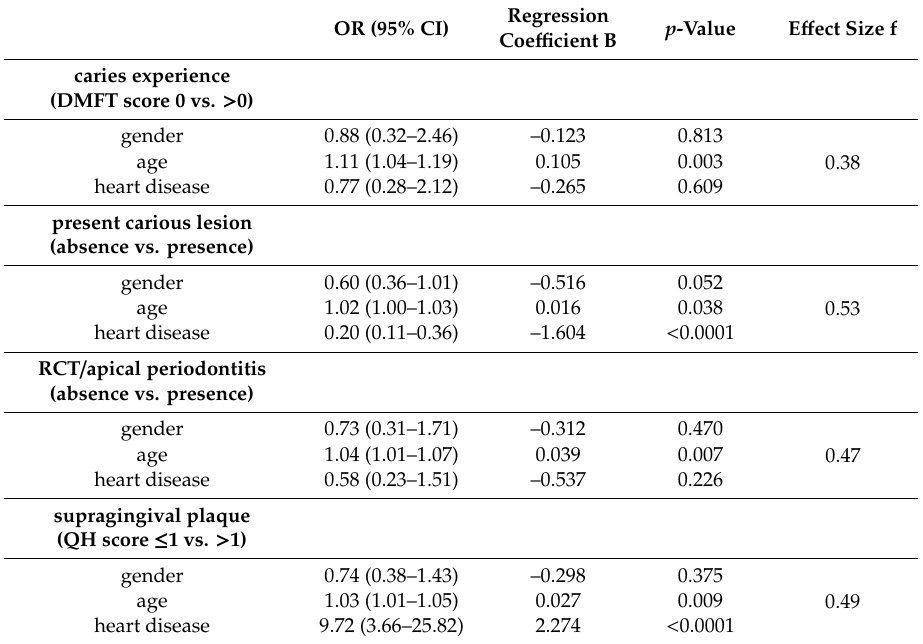
Table 4. Results of binary logistic regression analysis using previous caries experience, present unrestored carious lesions, previous root canal treatment and / or apical periodontitis, supragingival plaque and periodontal bone loss as dependent variables. Significance of regression coe ffi cient B has been tested with Wald test, results are presented as p -values. The e ff ect size f has been calculated with Nagelkerkes